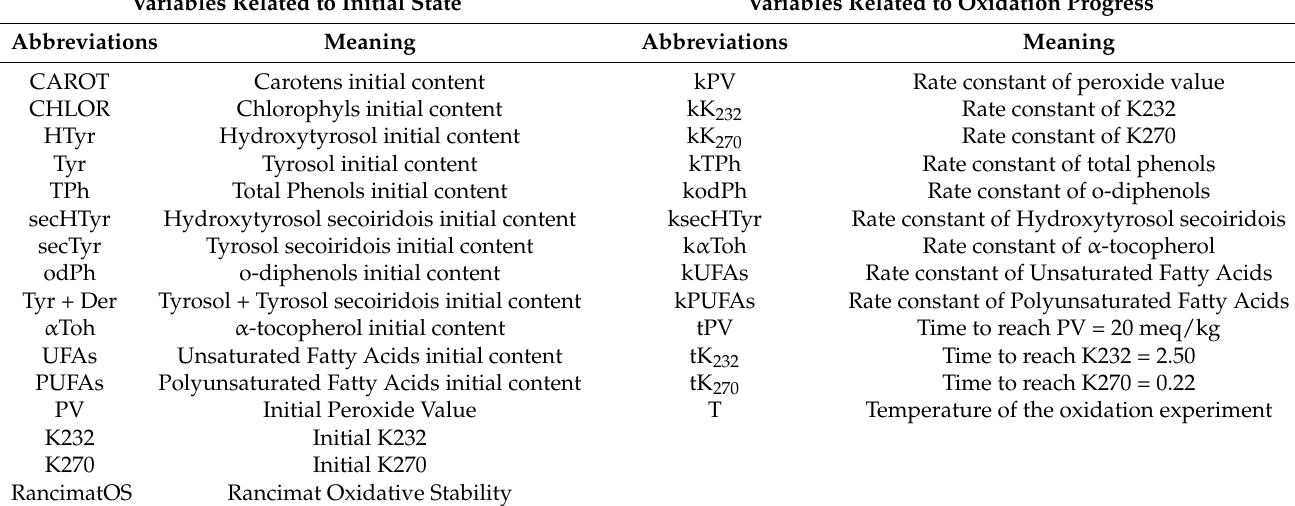
Table 4. Variables used in